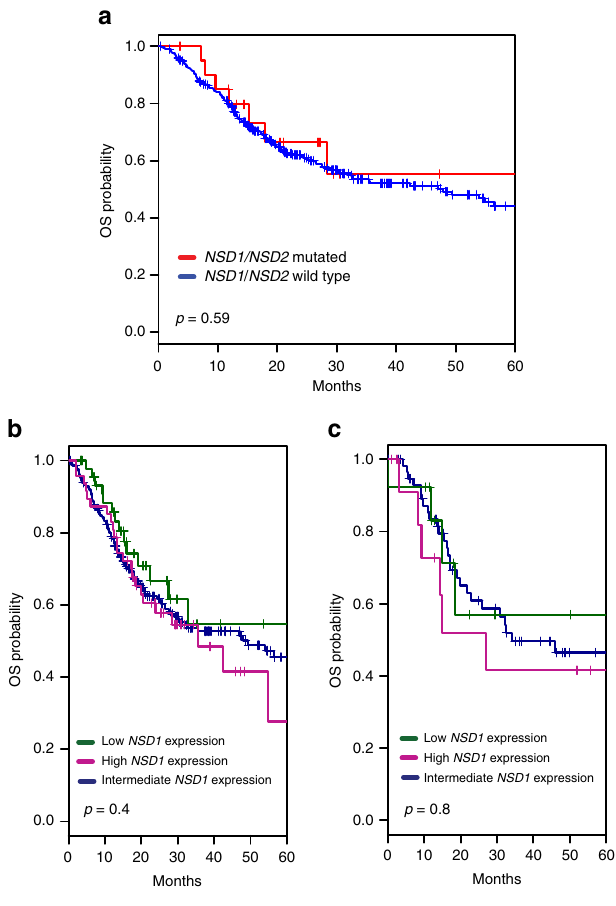
Fig. 3 Kaplan – Meier curves for overall survival (OS) based on NSD1/NSD2 mutation and NSD1 expression status in nonlaryngeal and laryngeal tumors, based on TCGA data. a Kaplan – Meier curves showing OS for nonlaryngeal HPV – (including oral, oropharynx, and hypopharynx) SCCHN. Red and blue curves show NSD1- and NSD2- mutated, and NSD1/NSD2 wild-type cases, respectively; OS differences are not signi fi cant ( p -value from log-rank test). b Kaplan – Meier curves showing OS differences for patients with NSD1 wild- type oral cancers trichotomized based on low ( < or 15% quantile), intermediate ( > 15% and < 85% quantiles), or high ( > 85% quantile) NSD1 expression. c Kaplan – Meier curves showing OS for patients with NSD1/ NSD2 wild-type laryngeal cancers, with NSD1 expression trichotomized as